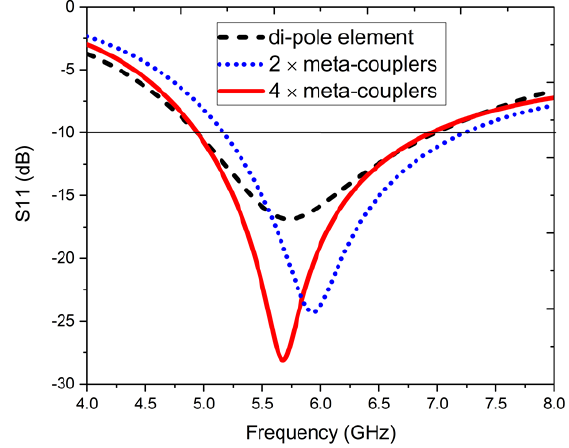
Figure 3. S11, dB parameters of different configurations for the one-element antenna configuration.